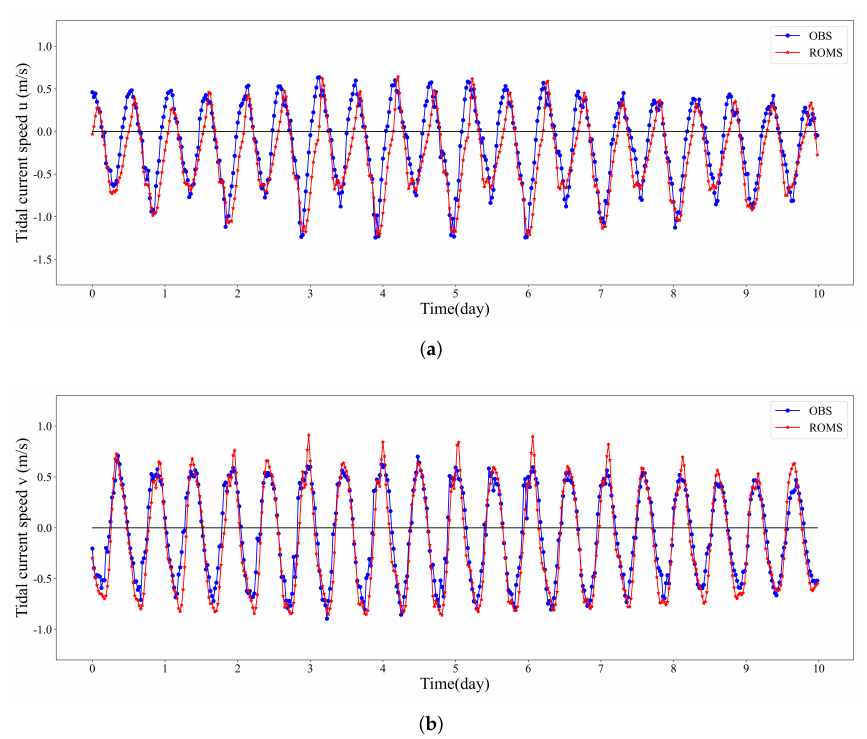
Figure 6. Comparison results of the tidal current speed from observation and the ROMS. ( a ) Compar- ison of the simulation data and actual value for u in ADCP2. ( b ) Comparison of the simulation data and actual value for v in